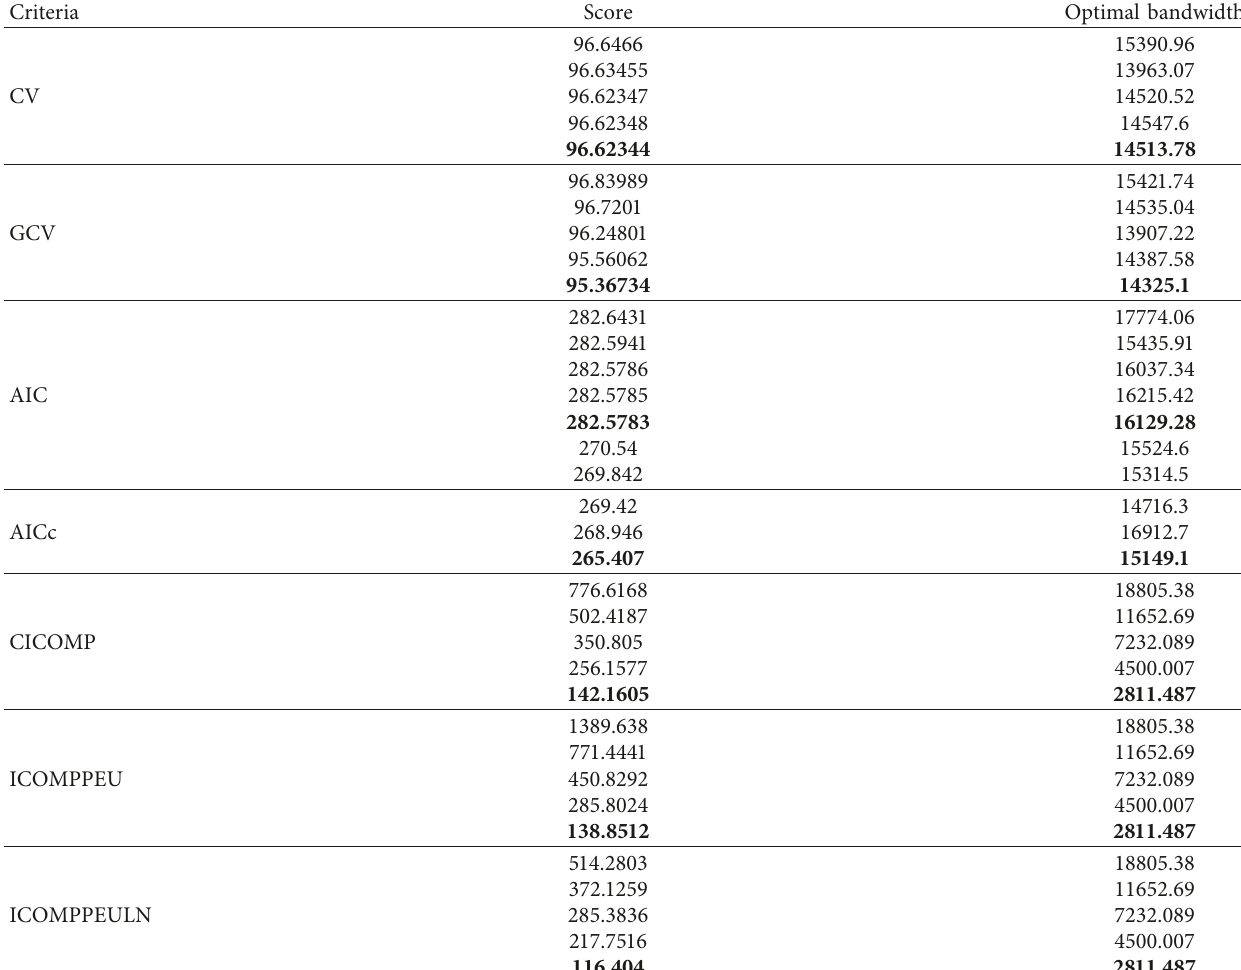
Table 1: Optimal bandwidth for different